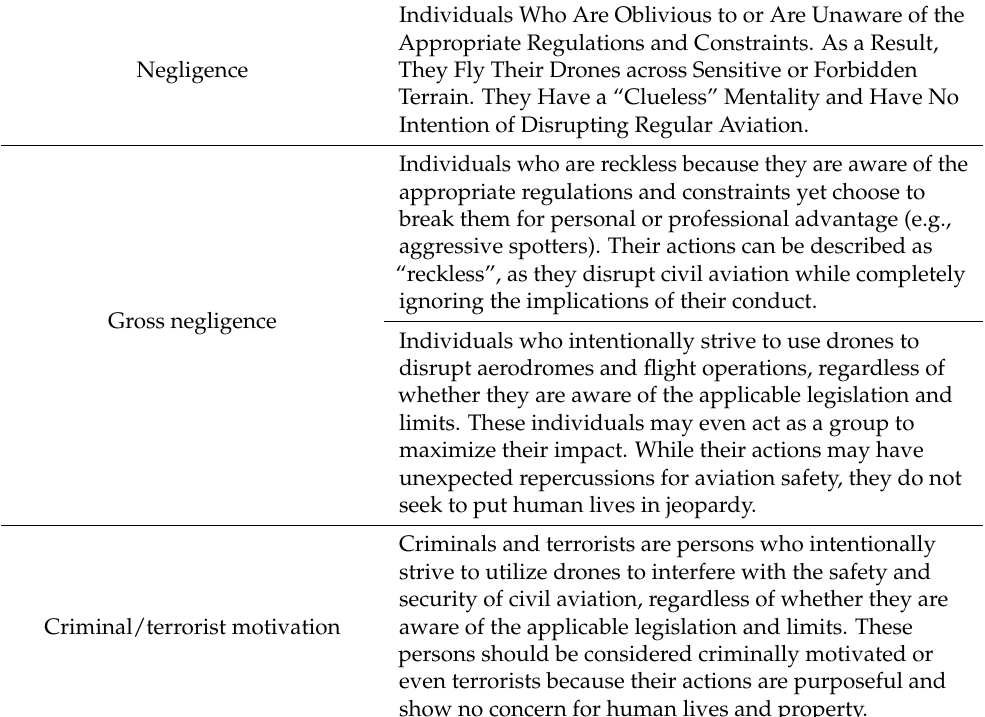
Table 2. EASA categorization of intention/motivation of pilots of unauthorized